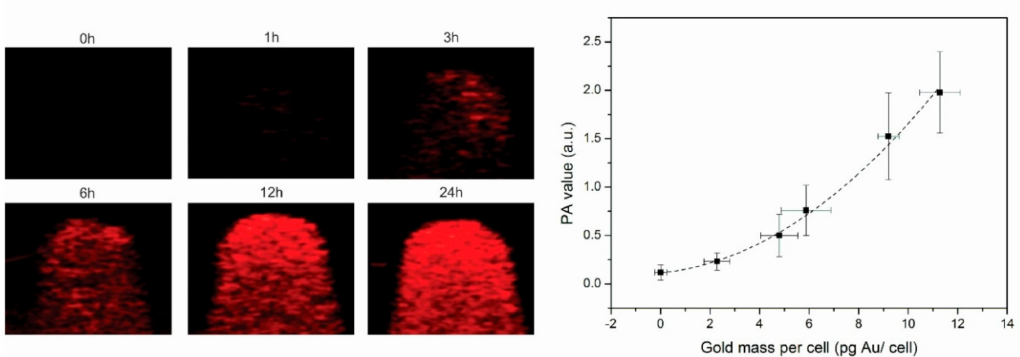
Figure 3. Left : PA images of a phantom loaded with tumor cells (n = 3) incubated for di ff erent time slots with the nanostars. Right : PA signal plotted for the di ff erent gold masses per cell, where the dotted line suggests an exponential relation between those 2 variables.